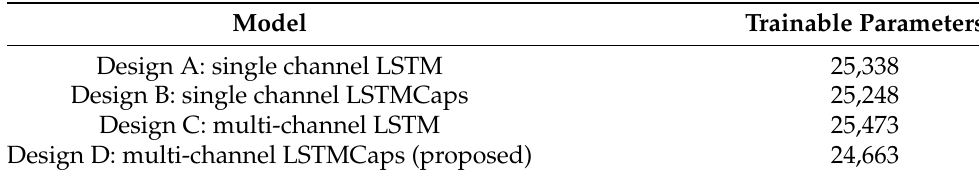
Table 2. Trainable parameters for each NN model variant, which were kept as similar as possible for experimental rigour.